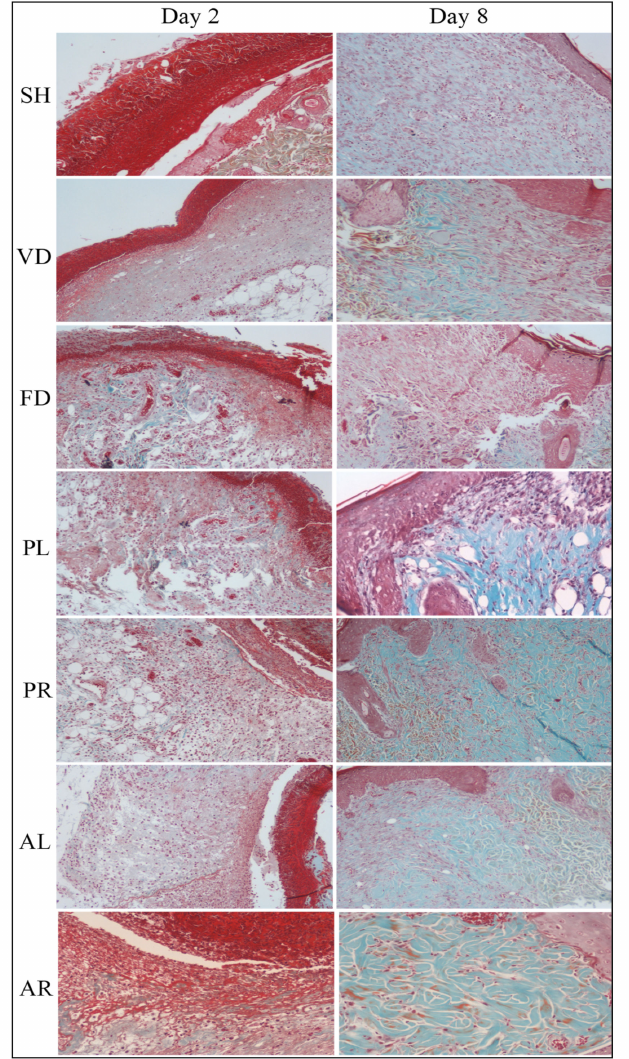
Figure 5. Histopathological view of collagen deposition in wounded skin tissue evaluated by Masson– Goldner trichrome (MGT) staining of seven male rat experimental groups: SH, VD, FD, PL, PR, AL, and AR. Pictures of stain are at 20 × magnification. Blue staining indicates collagen deposition. SH: sham control group (without treatment); VD: treated with vehicle (Cetomacrogol ointment); FD: treated with flavine (Acriflavine 0.1%); PL: treated with 1.0% concentration of MPvp leaves extract; PR: treated with 1.0% concentration of MPvp stem roots extract; AL: treated with 2.0% concentration of MPva leaves extract; AR: treated with 2.0% concentration of MPva stem roots extract. Bar scale: 20 µ